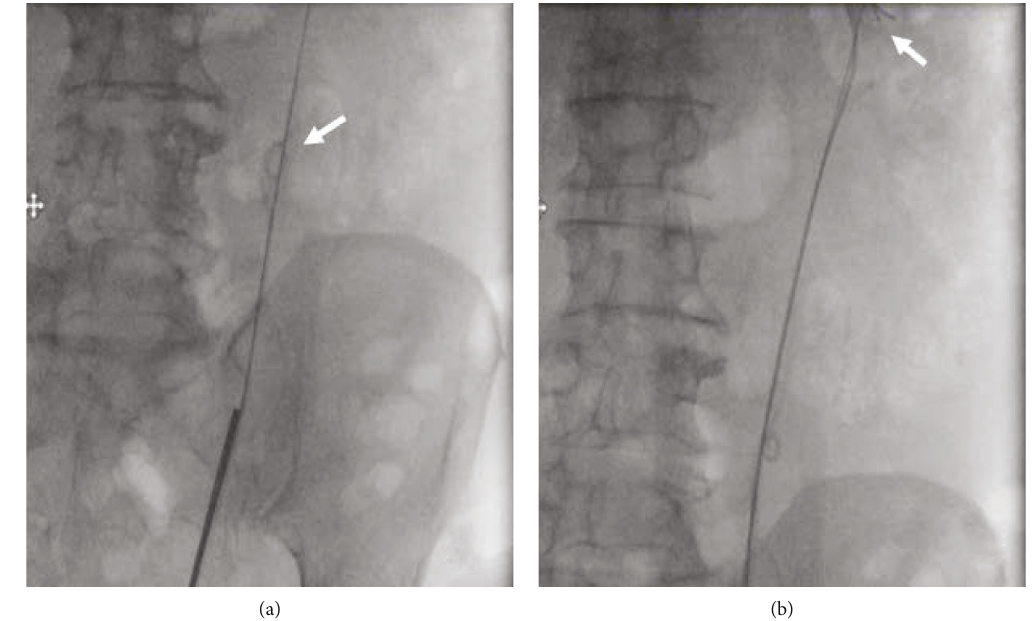
Figure 2: Intraoperative fl uoroscopy images from patient #2. (a) The coiled stent in the midureter where it became lodged (arrow). The ureteroscope was unable to be advanced beyond the midureter. (b) 3 hydrophilic guidewires successfully passed to the kidney (arrow), at which point the stent was removed